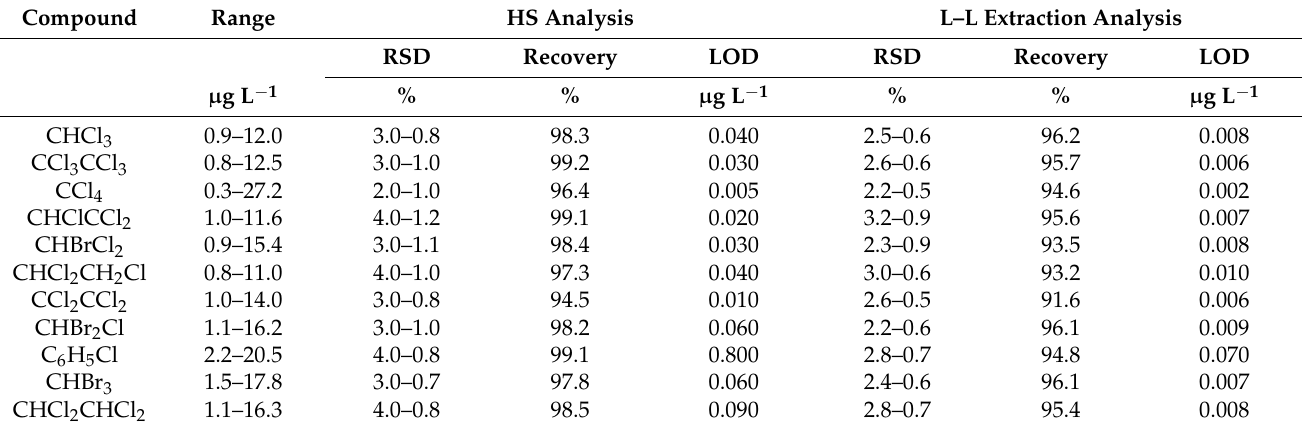
Table 1. Linearity range ( µ g L − 1 ), relative standard deviation (RSD, %), recoveries (%) and limit of detection ( µ g L − 1 ) in HS- and LL-GC-ECD analyses for the halocarbons investigated in this work.